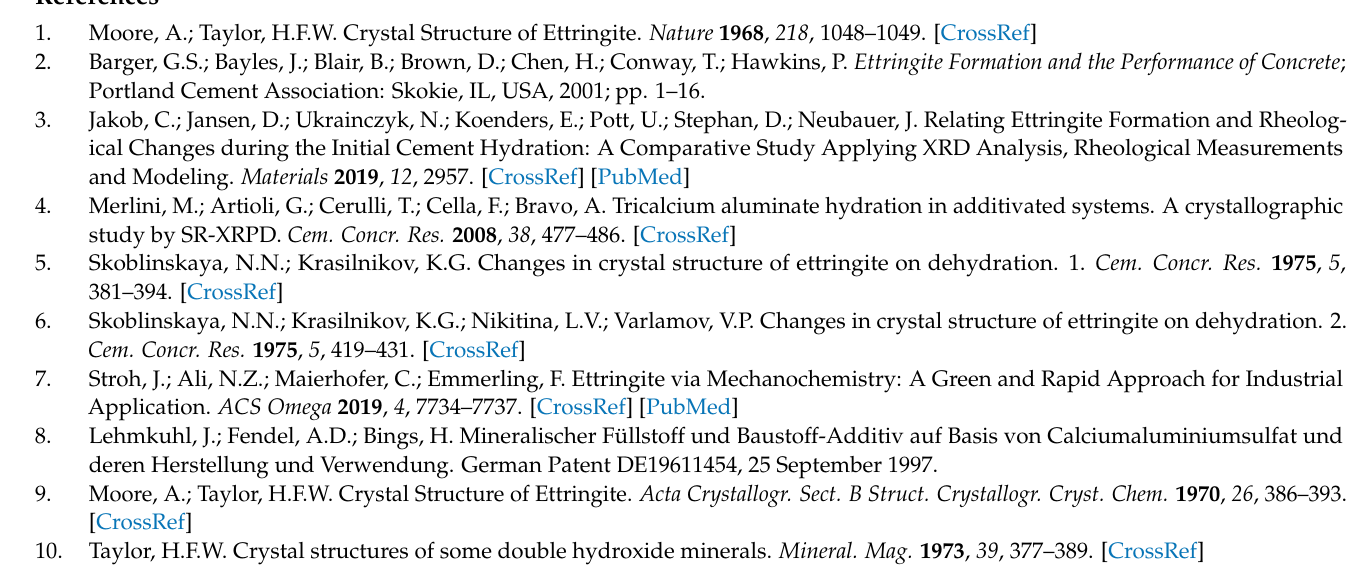
Figure 8; retrogression of the cell of synthetic ettringite after treatment at two different levels of low pressure (4.0 mbar and 60 µ bar) for various durations (up to 72 h); R wp , R exp and GOF derived by Pawley fit [4,5] [19,40].